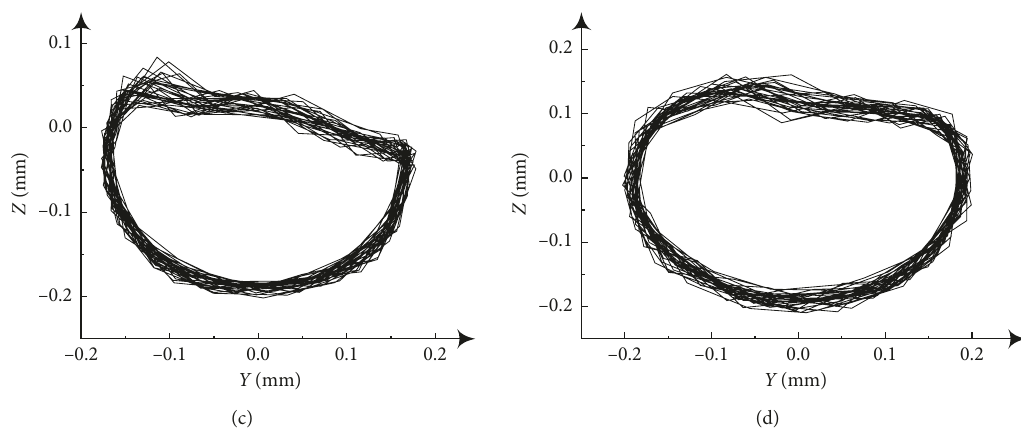
Figure 15: Relative tracks at T � 600K and (a) 15000rpm (b) 20000rpm, (c) 25000rpm, and (d)